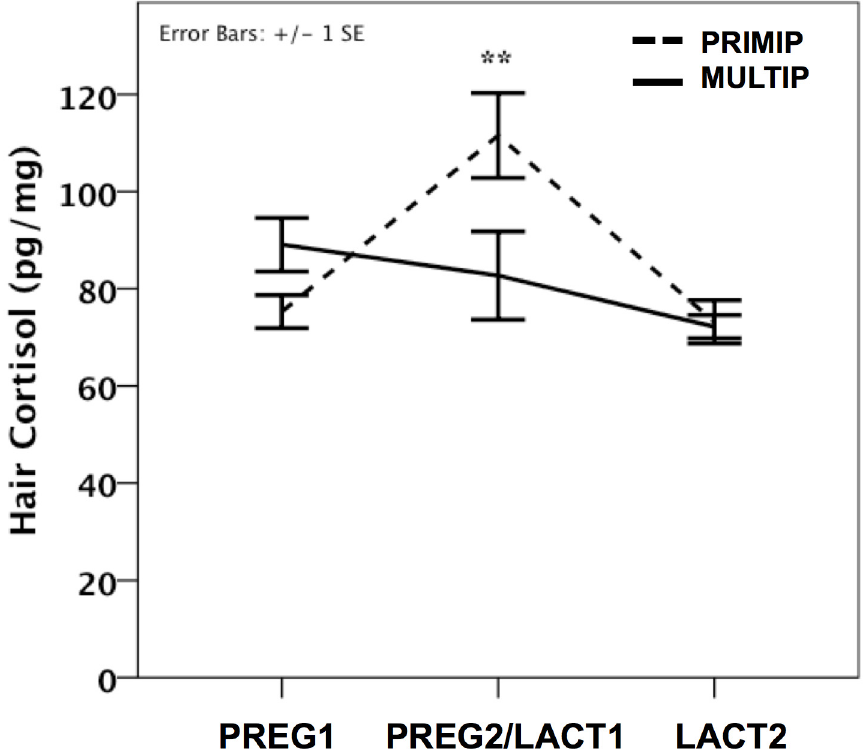
Fig 1. Parity differences in hair cortisol concentrations across pregnancy and lactation. PRIMP = primiparous, MULTIP = multiparous. PREG1 = mean ± SE gestational age 124.9 ± 8.7 days; PREG2/ LACT1 = mean ± SE gestational age 230.1 ± 8.7 days or mean ± SE postnatal age 60.1 ± 8.7 days; LACT2 = mean ± SE postnatal age 159.2 ± 8.8 days. ** p < 0.01.